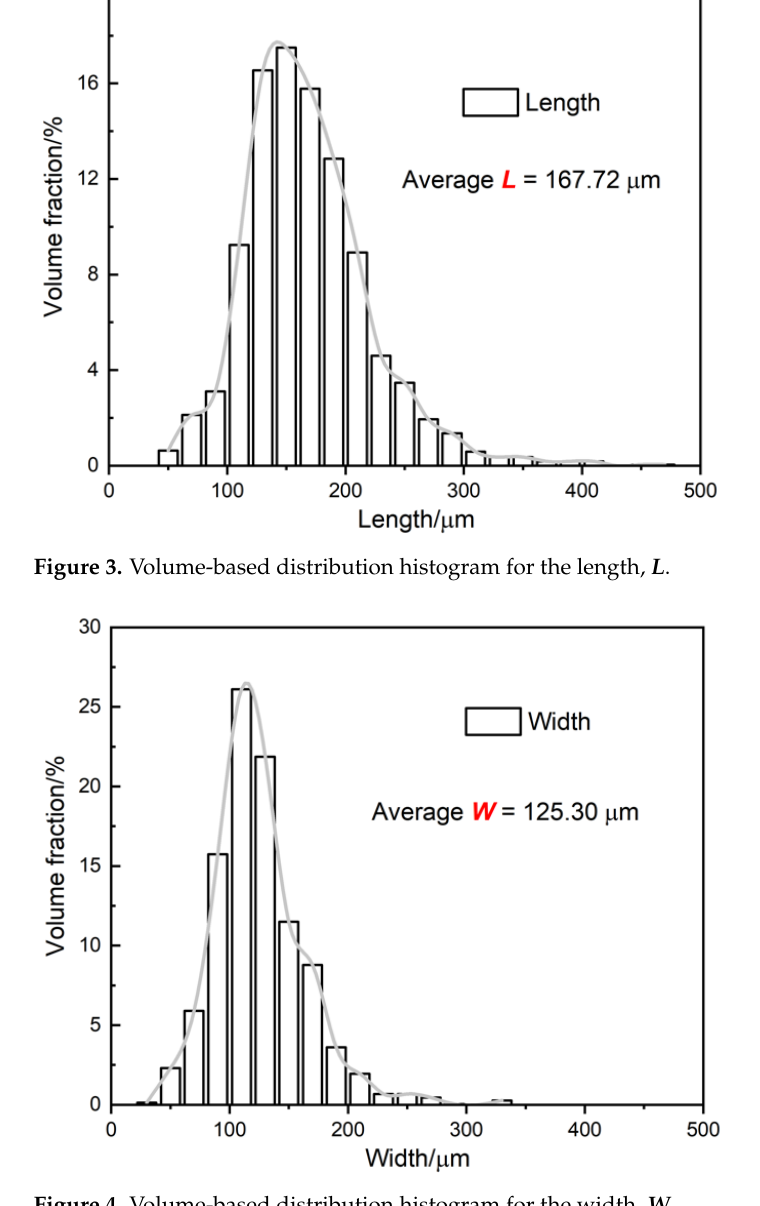
Figure 4. Volume-based distribution histogram for the width, W .